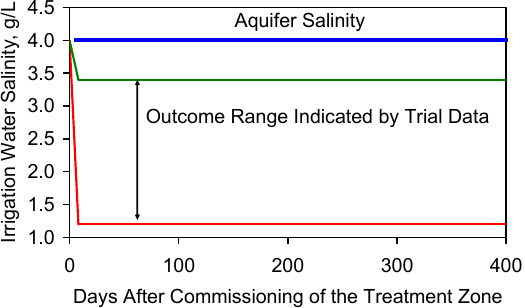
Figure F5. Change in salinity of the irrigation water abstracted from the modeled Aquifer Treatment Zone with time. Aquifer salinity = 4 g/L. R rci = Reinjection ratio = 480/500. Injection at 50–60 m from the abstraction well; n = 0 m 3 · day − 1 ; Leakage = 0%; B S range taken from Tables E1 and F1. Aquifer thickness = 1 m.